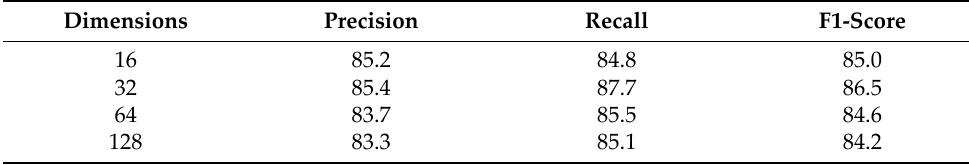
Table 7. Performance comparison with different LSTM cell sizes.